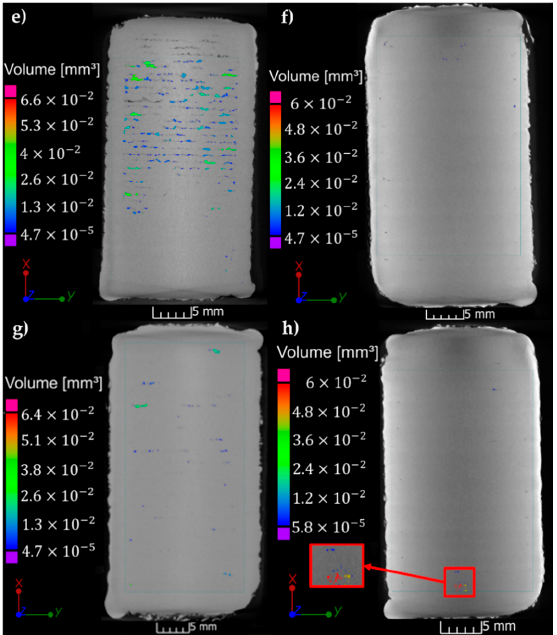
Figure 7. XCT slices in the areas with the most pronounced porosity of samples ( a ) S1, ( b ) S2, ( c ) S3, ( d ) S4, ( e ) S5, ( f ) S6, ( g ) S7, ( h ) S8. ( d ) S4, ( e ) S5, ( f ) S6, ( g ) S7, ( h ) S8.